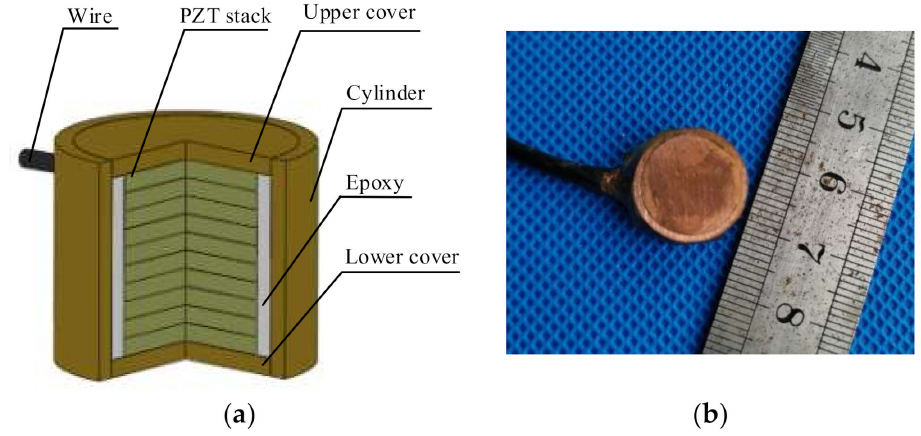
Figure 3. Structure of PiSSA: ( a ) structure of PiSSA; and ( b ) the assembled